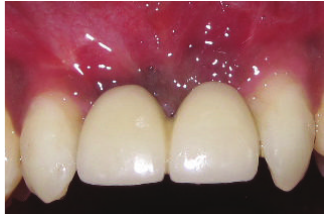
Figure 3: Between implants bone block fixed by using Titanium screw.